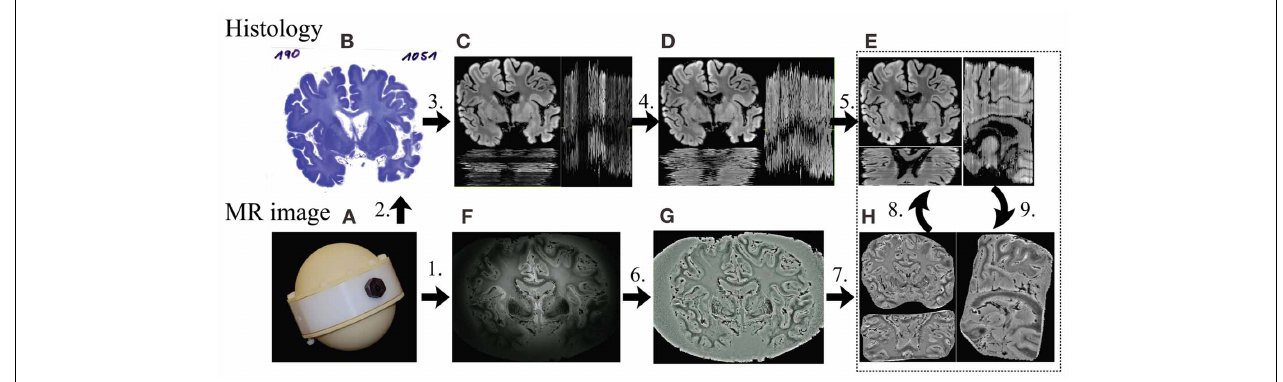
FIGURE 2 | Framework of the MRI-guided histology reconstruction. 1. MRI measurement (F) with the container (A) at 7T; 2. Standard processing of histology and staining (B) ; 3. Converting color to gray, removing the background (C) ; 4. Inter-section intensity normalization using histogram